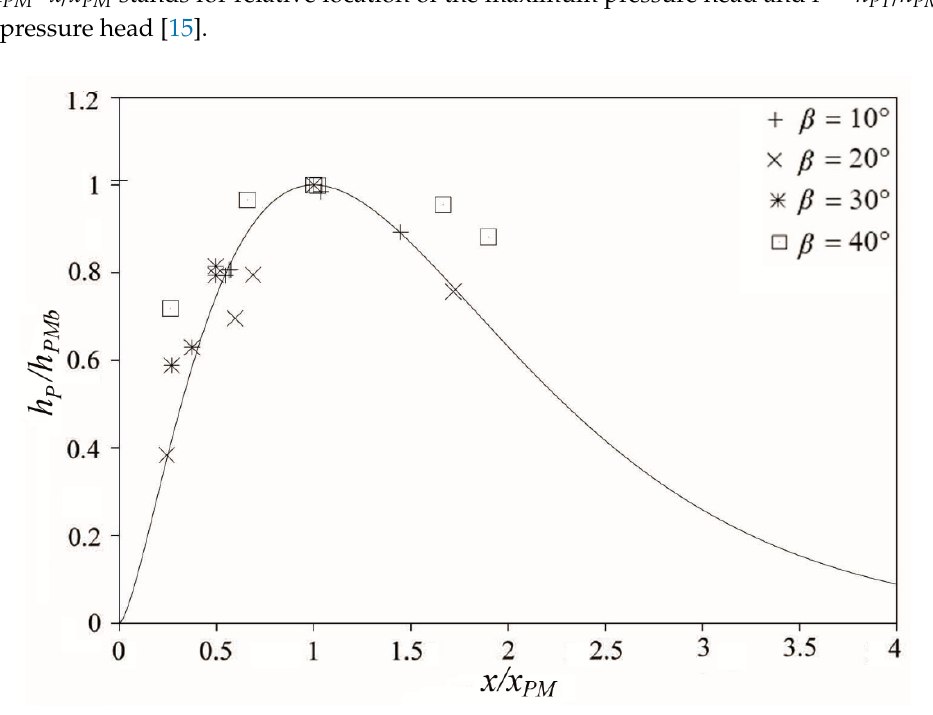
Figure 3. Local pressure head distribution along the bucket centerline: (—) calculated values with Equation (5) in [15] versus the computed values from the present study (symbols).